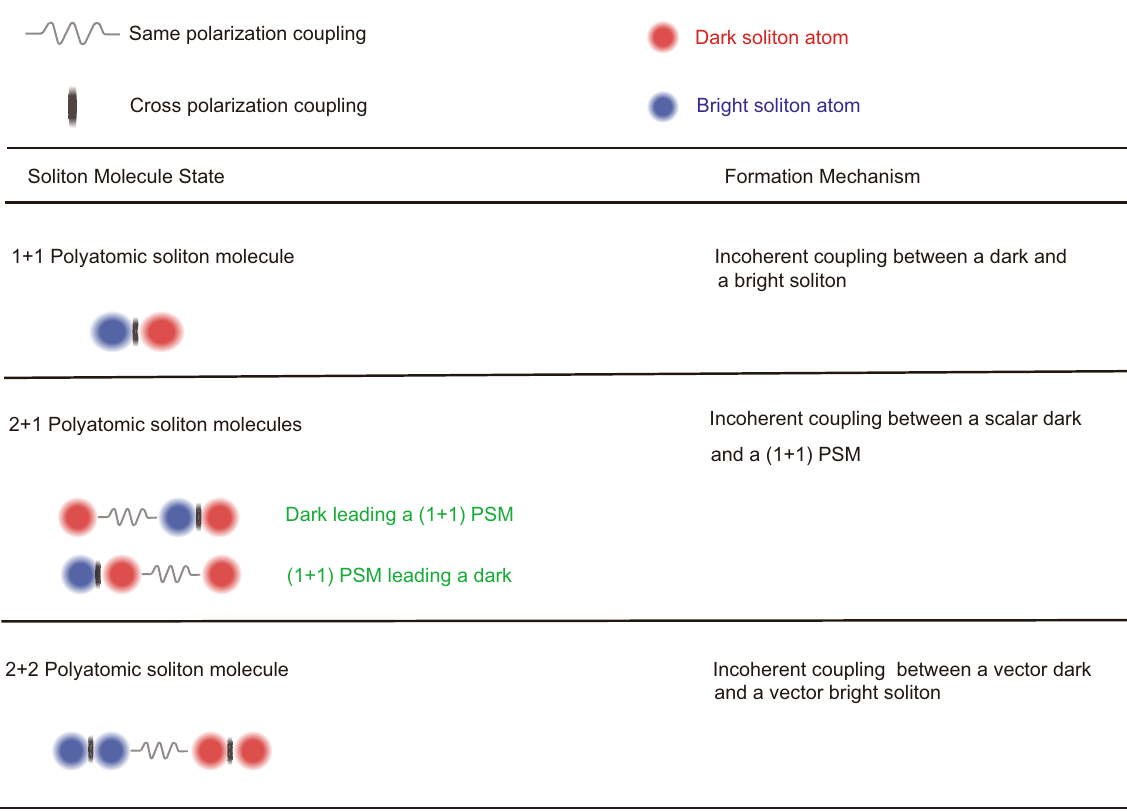
A schematic illustration on the structure of each soliton molecule. Red-shaded circle: atomic representation for a dark soliton formed in the normal GVD regime; blue- shaded circle: atomic representation for a bright soliton formed in the anomalous GVD regime; spring and vertical stripe notations correspond to intramolecular bonds. Stripe notation: the intramolecular bond between orthogonally polarized solitons. Spring notation: the intramolecular bond between solitons with the same polarization and different